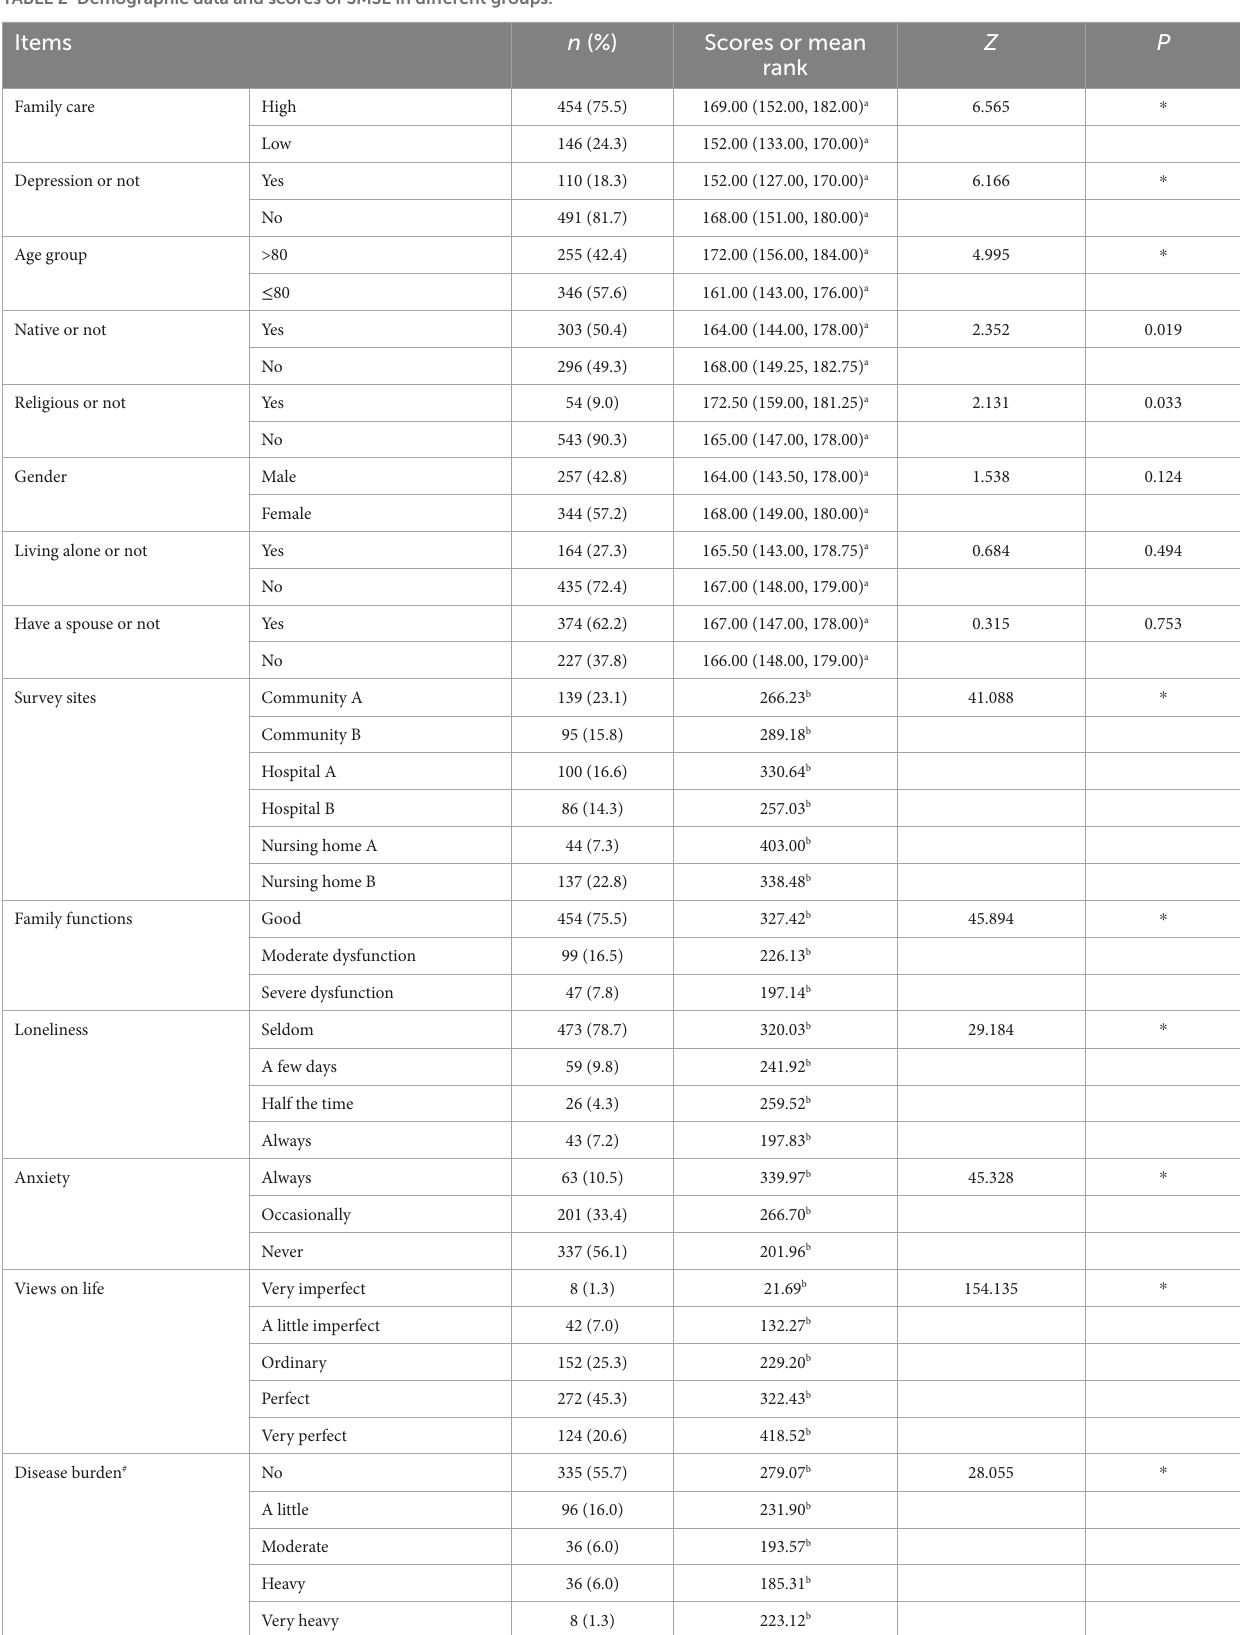
TABLE 2 Demographic data and scores of SMSE in different